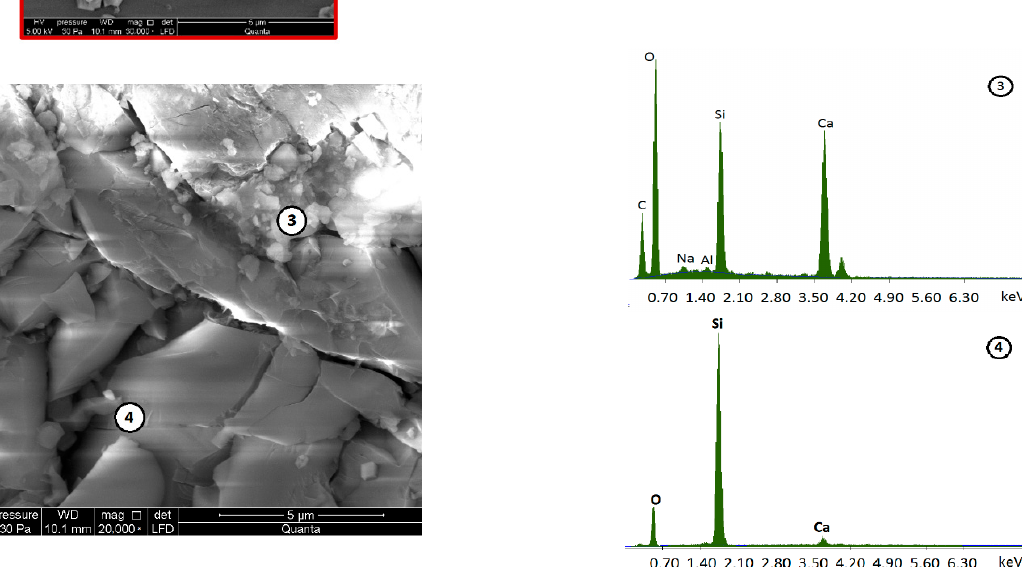
Figure 3. Scanning electron microscope image of the reclaimed cement concrete (RCC) using the Quanta Feg 250 SEM and EDS spectrum at measuring points 1–4.